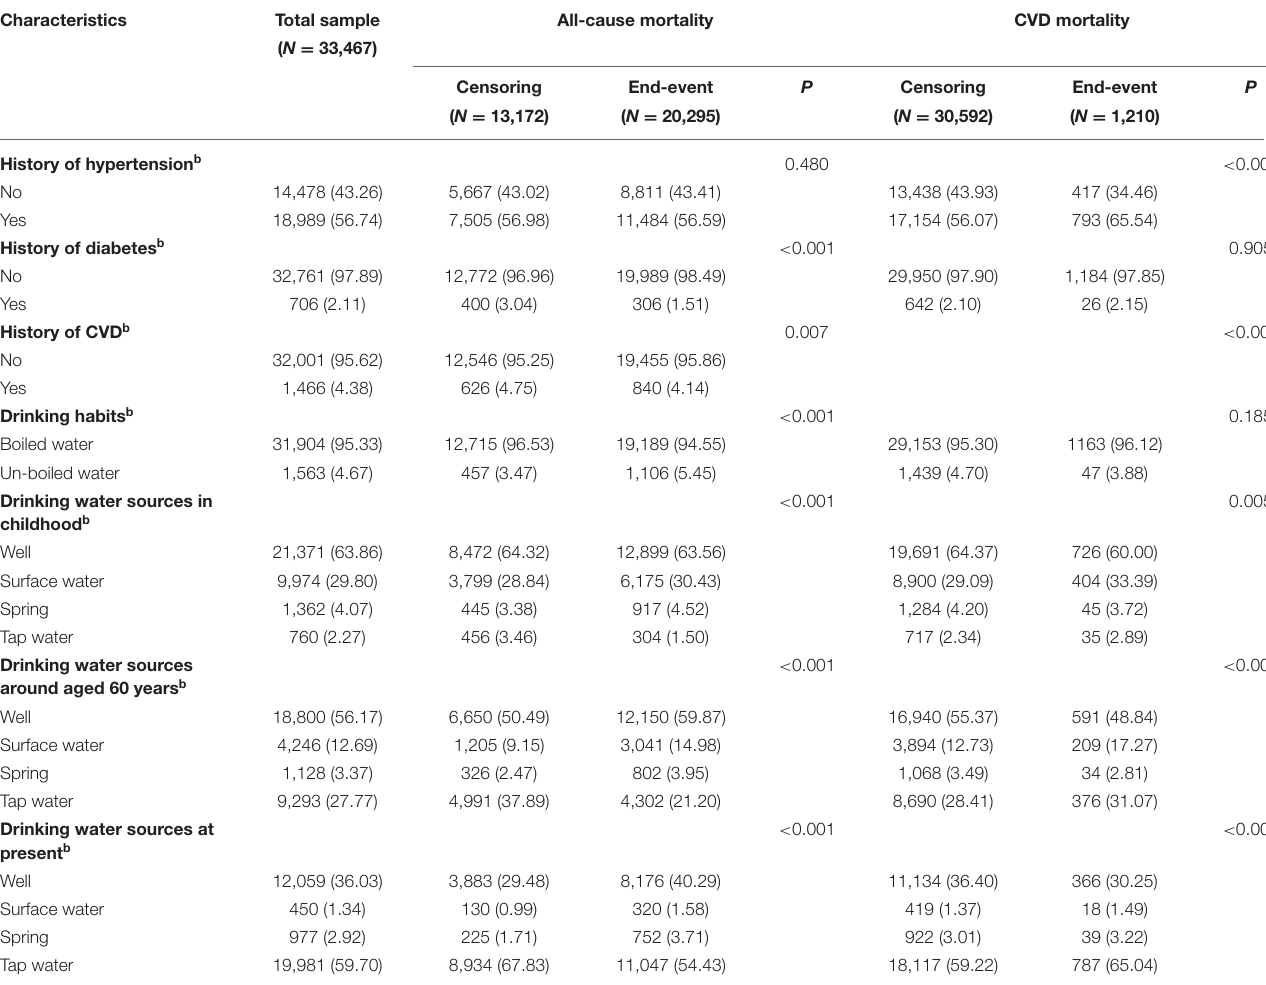
The Associations of Lifespan Drinking Water Sources and Habits With All-Cause Mortality Compared to unboiled water, boiled water was not associated